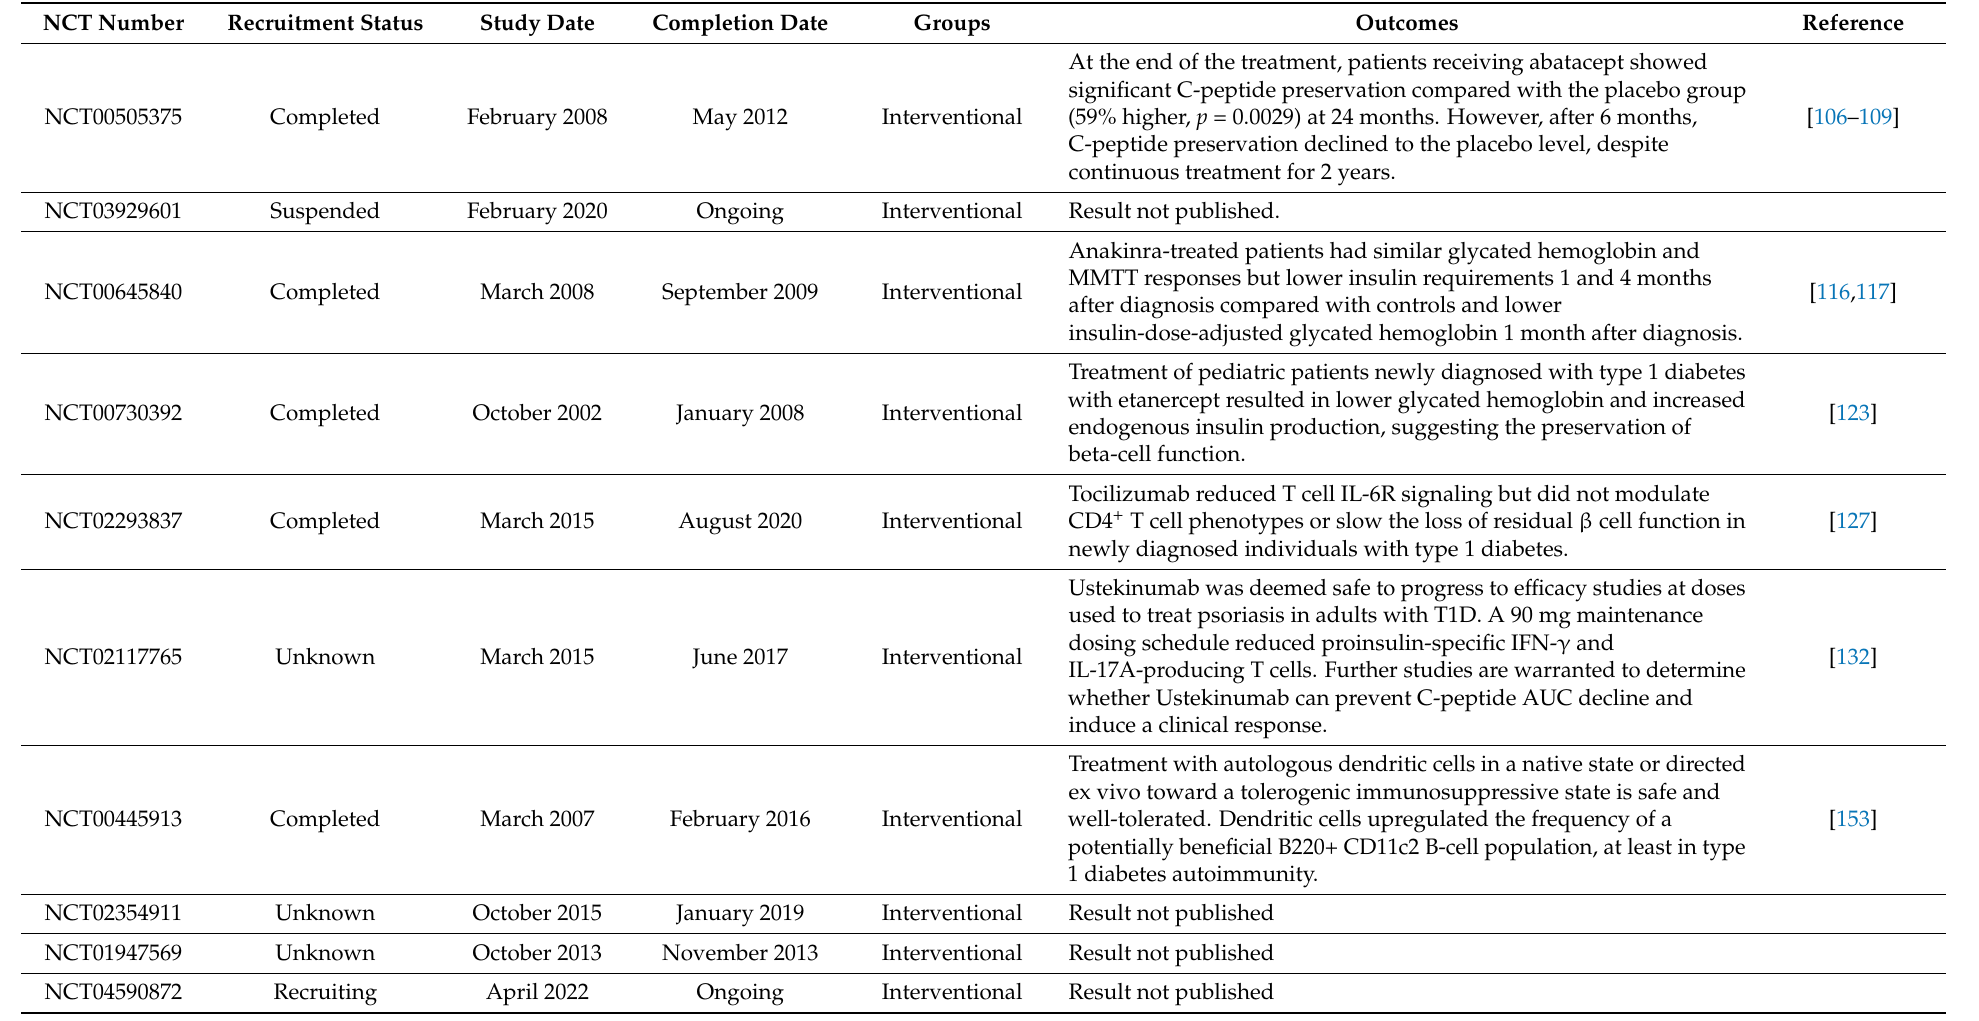
Table 2. Summary of the clinical trials mentioned in the